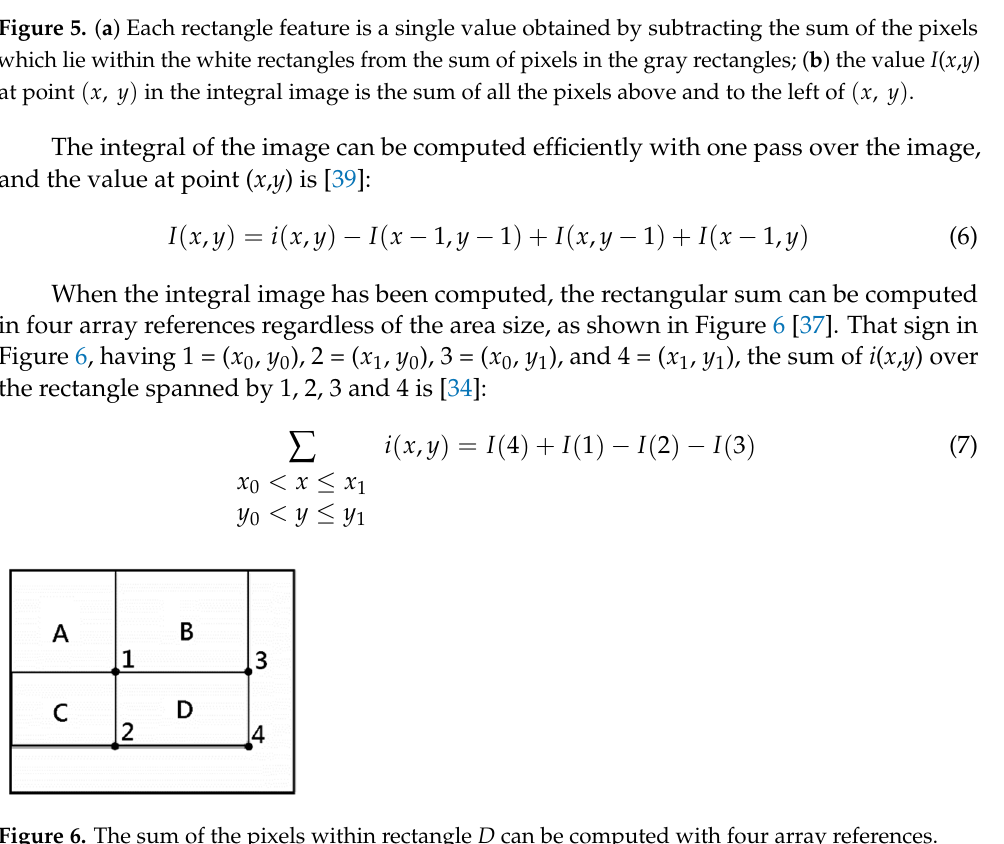
Figure 5. ( a ) Each rectangle feature is a single value obtained by subtracting the sum of the pixels which lie within the white rectangles from the sum of pixels in the gray rectangles; ( b ) the value I ( x , y ) at point ( x , y ) in the integral image is the sum of all the pixels above and to the left of ( x , y ) . The integral of the image can be computed efficiently with one pass over the image, and the value at point ( x , y ) is [39]: